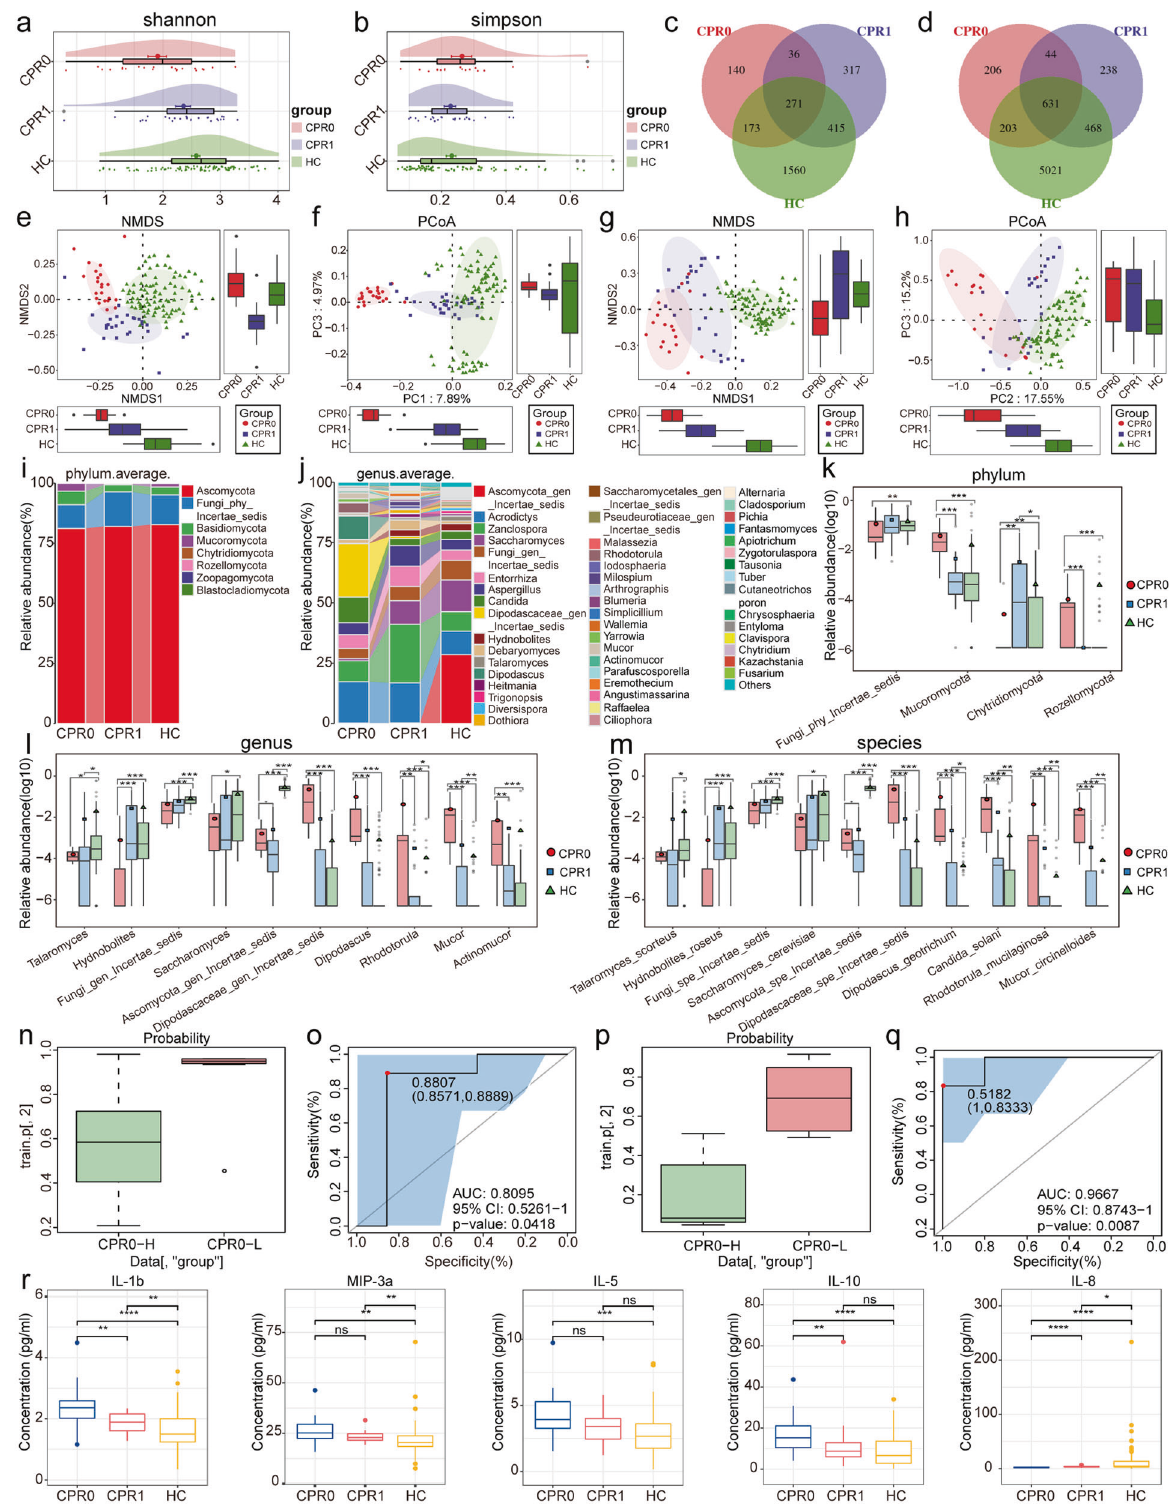
and OTU5, OTU19, OTU29, OTU69, OTU8088 in fecal fungal microorganisms. In the association analysis of 18 oral fungal OTUs and 8 fecal fungal OTUs with 10 clinical indicators, we found that neutralizing antibody and IgG were negatively correlated with monocytes and total bile acids, and positively correlated with